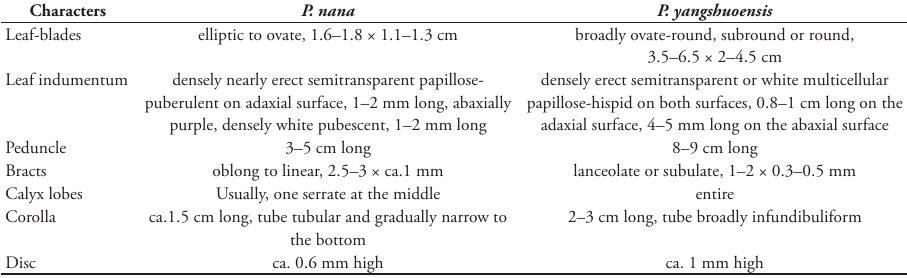
Table 1. Detailed comparison of Primulina nana and its relative P. yangshuoensis